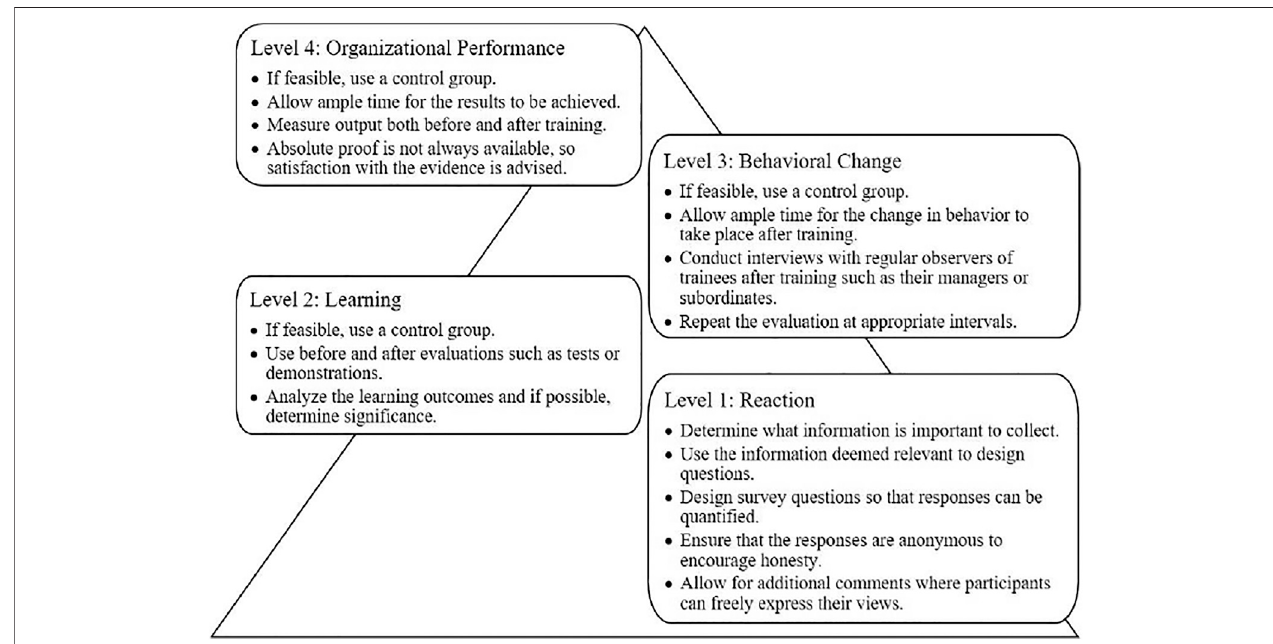
FIGURE 1 | Kirkpatrick model levels and guidelines (Kirkpatrick,